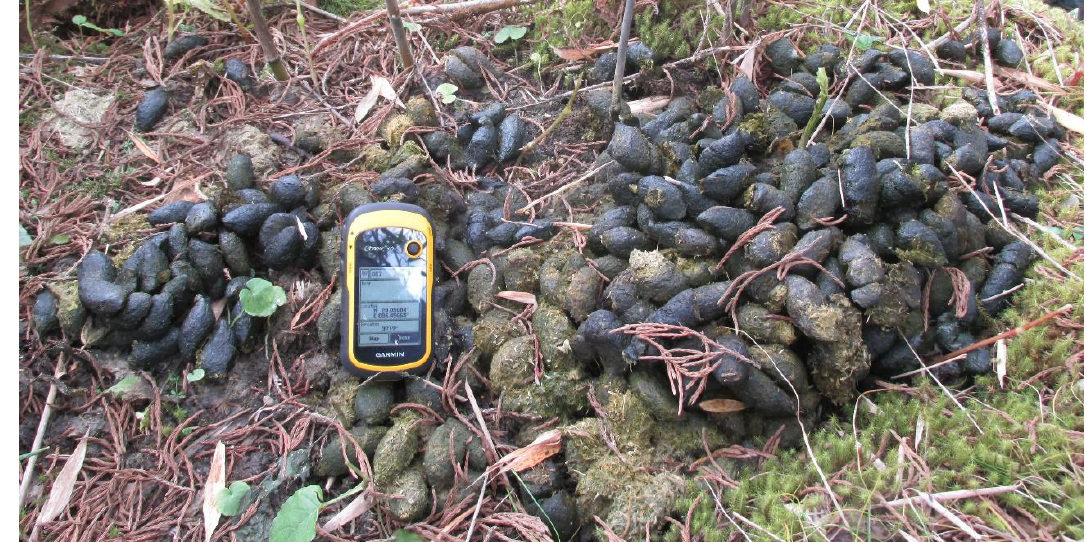
Figure 1. Red panda feces. Usually, fresh feces are greenish due to bamboo consumption in their diet. The color of the feces gradually fades with time. They use the same latrine sites for defecation where droppings of different ages can be easily seen (as in the figure). One animal can have many latrine sites within their home range. These latrine sites are believed to serve as territory markers. (Photo credit: Red Panda Network)